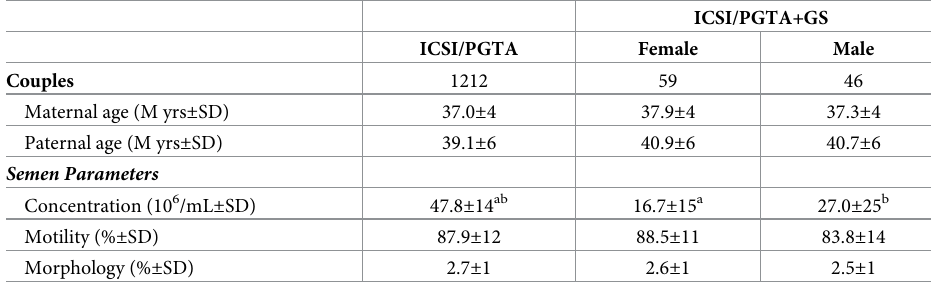
Table 1. Demographics and semen parameters for the control and study groups according to